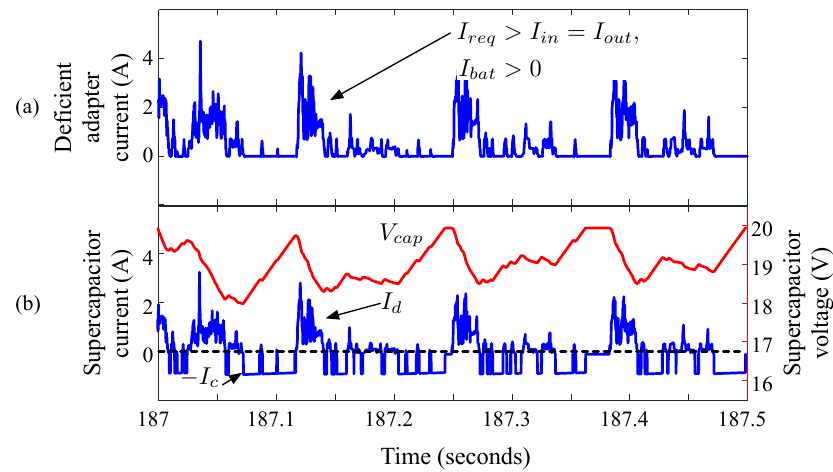
) /discharge ( ) current of the I c I d | | | | > 0 and I d = 0 and the I c | | > 0, I d | |